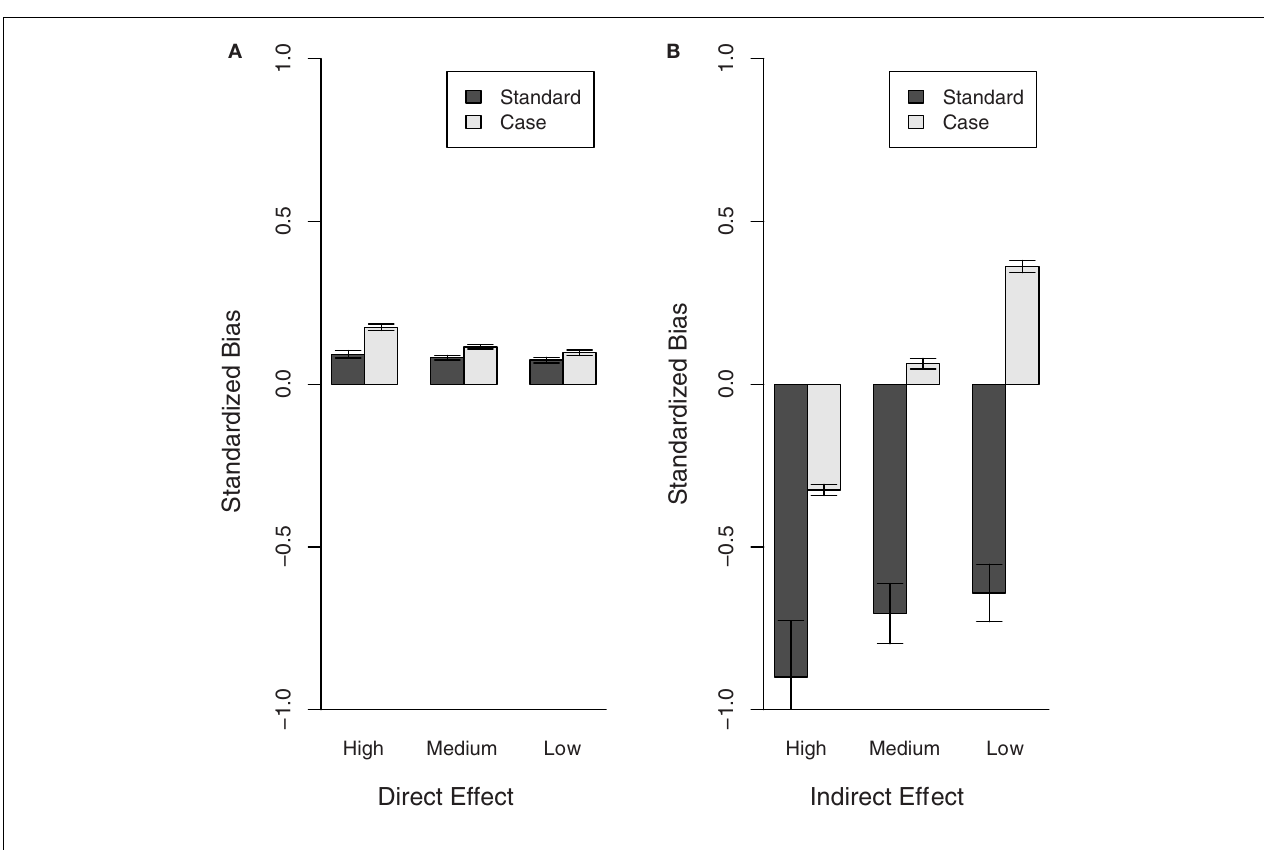
standardized to 1-bias if bias < 1 and 1/bias-1 if bias > 1, in order to show over and under estimation of the effects at the same scale. Thus values > 0 show over-estimation and values < 0 underestimation of the breeding values. (A) Direct effect, (B) indirect